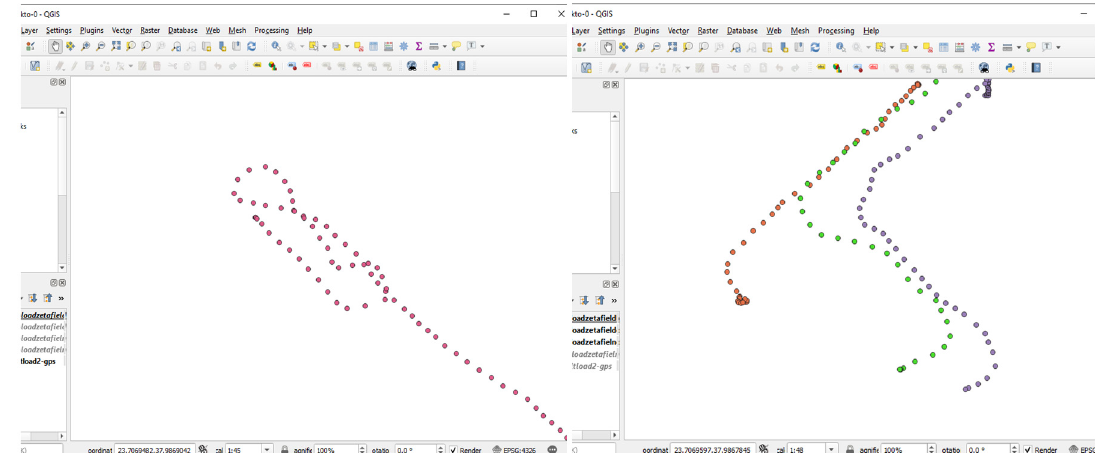
Figure 10. The activity traces of the robotic vehicle for smooth (in the left part) and rough (in the right part) terrains, as visualized using the QGIS software package.